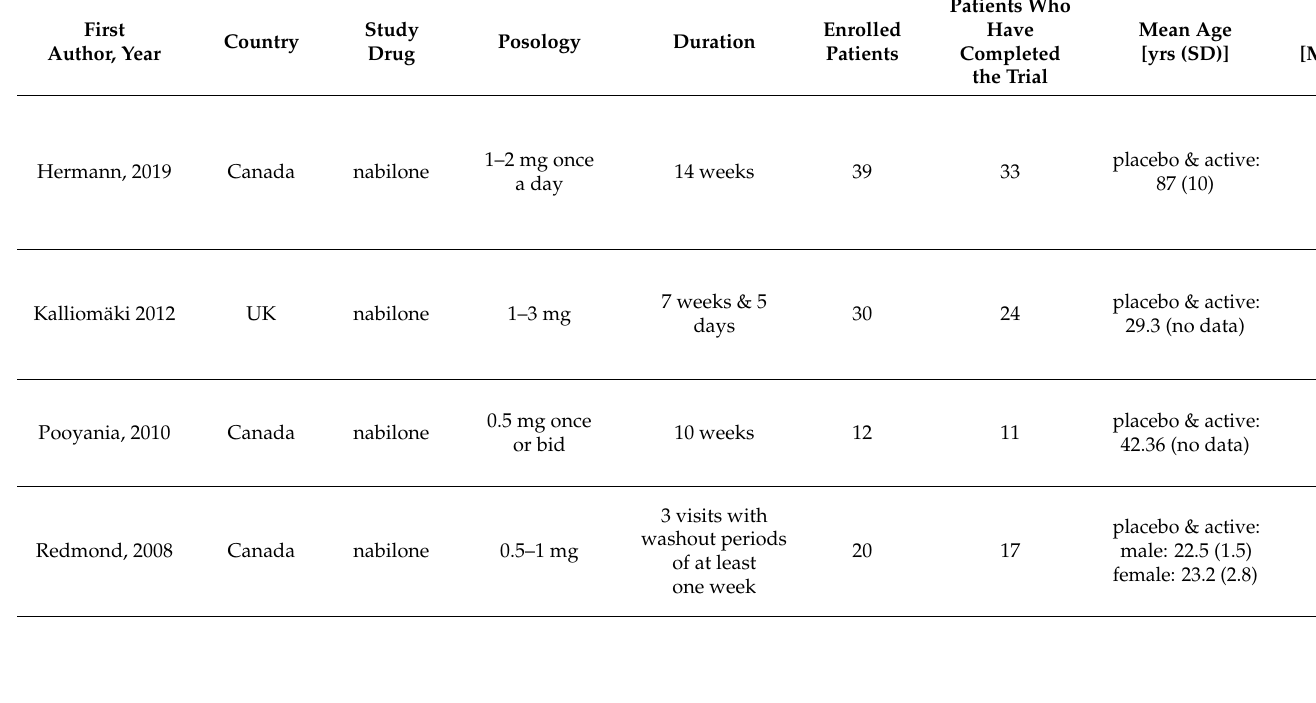
Table 1. Summary of nabilone